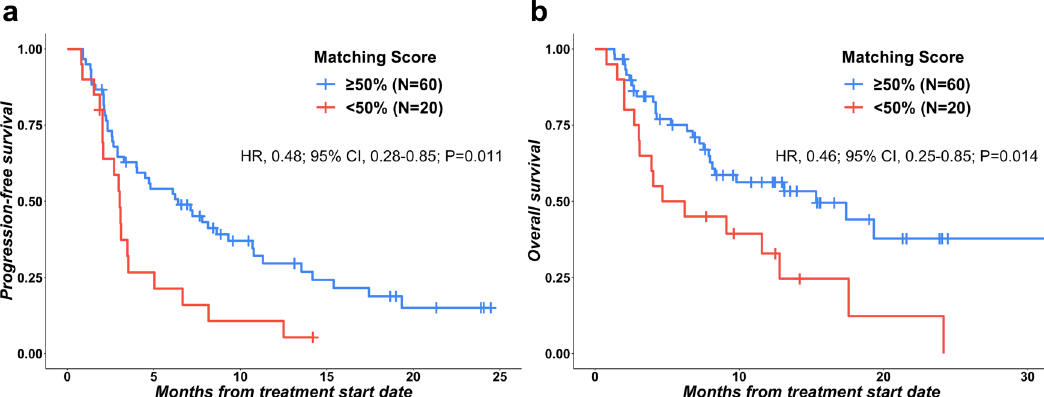
Fig. 2 Progression-free survival and overall survival based on Matching Score ( N = 80). a Progression-free survival (PFS) was signi fi cantly longer in patients with high ( ≥ 50%) Matching Score versus low (<50%) Matching Score (Hazard Ratio (HR), 0.48; 95% CI, 0.28 – 0.85; P = 0.011, univariate Cox regression) ( N = 80). Median PFS: High ( ≥ 50%) Matching Score, 6.4 months (95% CI: 3.3 – 9.5); Low (<50%) Matching Score, 3.0 months (95% CI: 2.5 – 3.6). b Overall survival (OS) was signi fi cantly longer in patients with high ( ≥ 50%) Matching Score versus low (<50%) Matching Score (Hazard Ratio (HR), 0.46; 95% CI, 0.25 – 0.85; P = 0.014, univariate Cox regression). Median OS: High ( ≥ 50%) Matching Score, 15.3 months (95% CI: 6.07 – 24.6); Low (<50%) Matching Score, 4.7 months (95% CI: 0.0 –